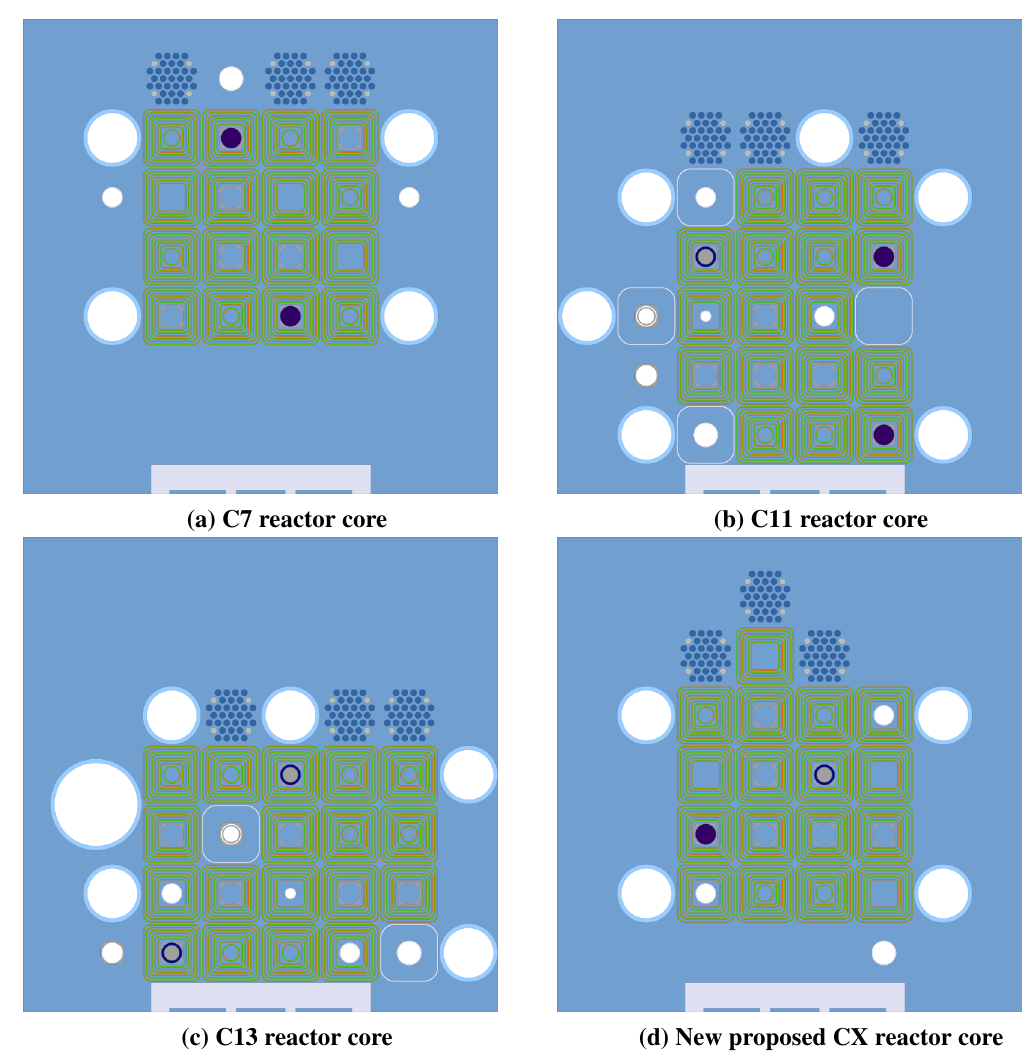
Figure 3: Analyzed core of the VR-1 reactor